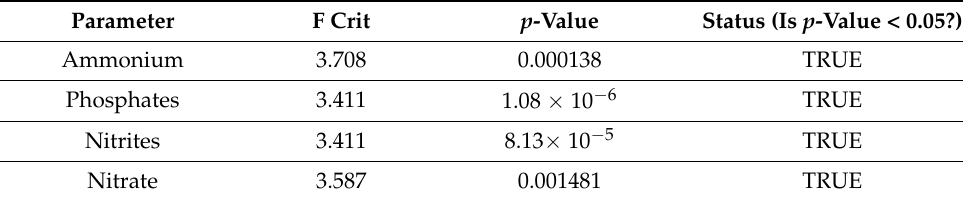
Table 6. ANOVA results from the different pore